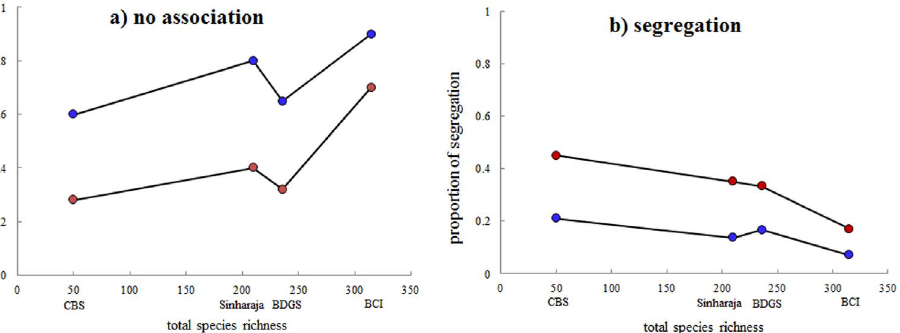
Figure 3. Relationship between richness and overall association patterns using the data from Badagongshan (BDGS) plot reported here and those reported in Wiegand et al. (2012) for Changbaishan (CBS) plot, Sinharaja plot and Barro Colorado Island (BCI) plot. (a) the proportion of no assciation type at 2 m (red circle) and 10 m neighborhood (blue circle); (b) the proportion of segregation type at 2 m (red circle) and 10 m neighborhood (blue circle).